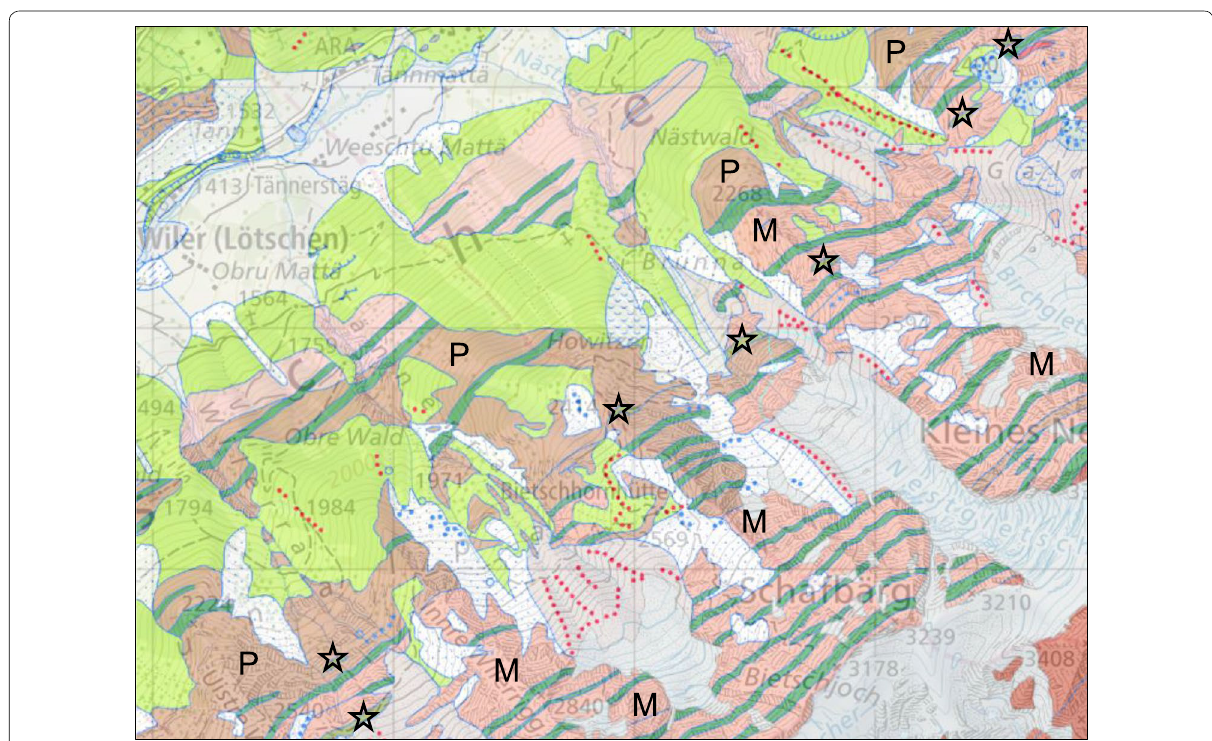
Fig. 4 Extract from the geological map of Lötschental, between Wiler (Swiss coordinates: 2 ʹ 626 516/1 ʹ 139 256, 1419 m) and Schafbärg (Swiss coordinates: 2 ʹ 630 084/1 ʹ 137 787, 3239 m). It shows the characteristic intercalation of banded amphibolite formations (green bands) and associated ultramafic bodies (indicated by stars) with migmatites (M) and paragneisses (P) (Source: GeoCover from https ://map.geo.admin